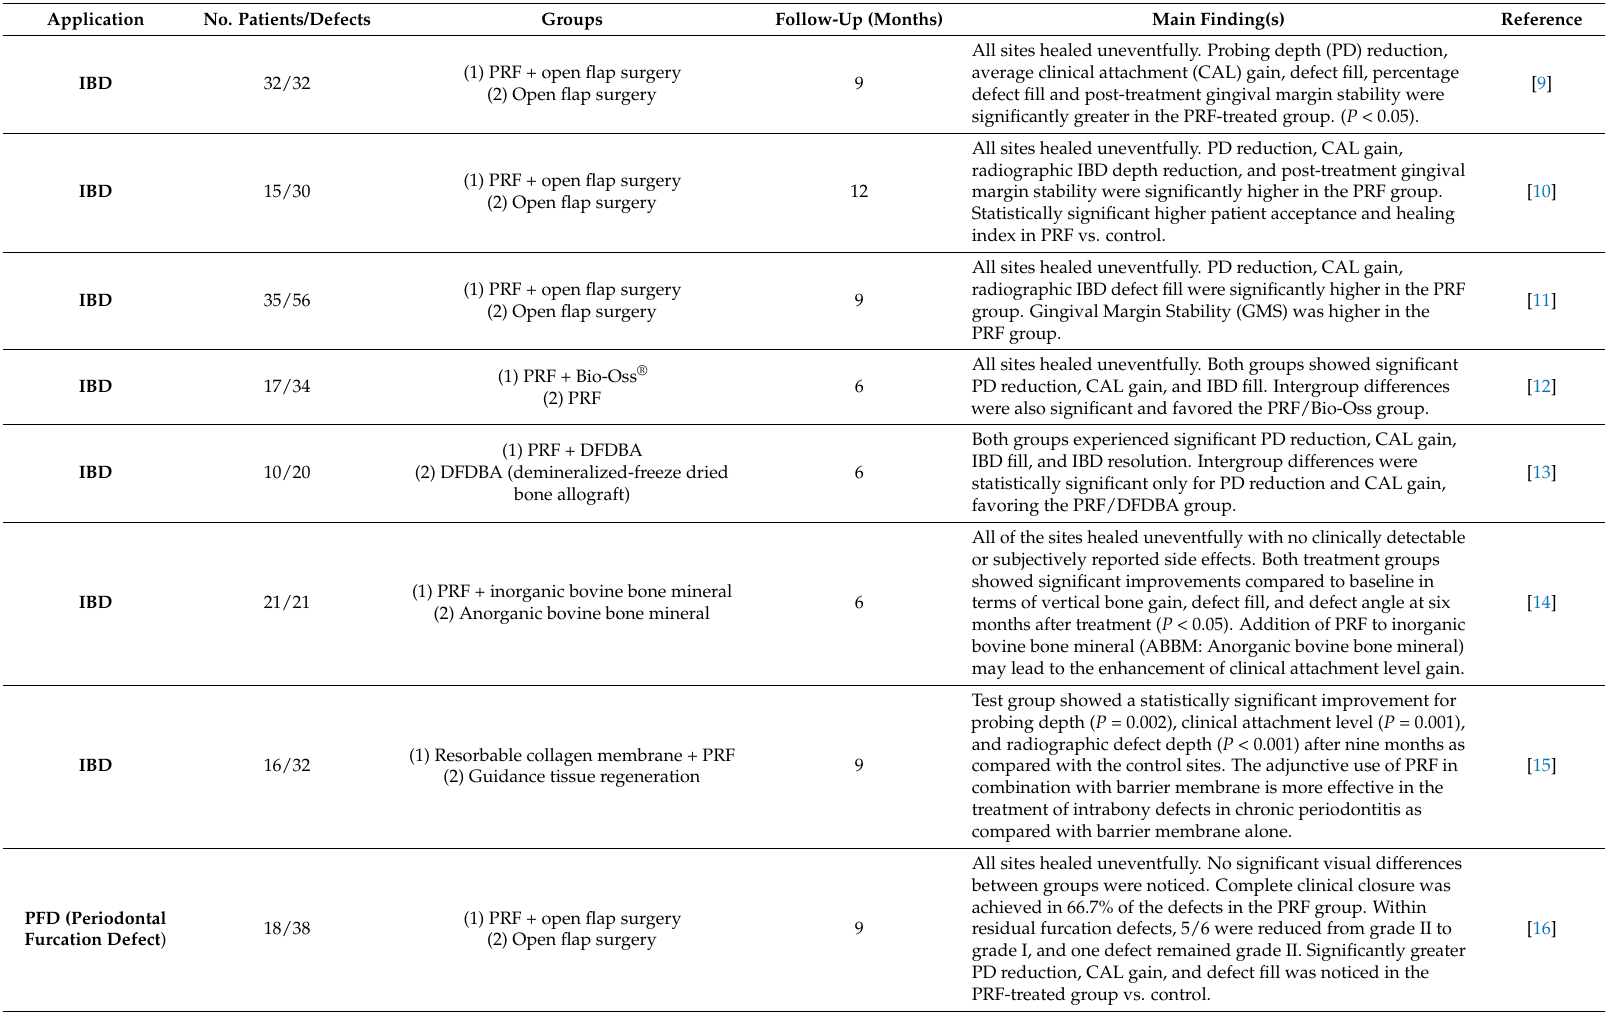
Table 1. Summary of clinical literature (randomized clinical trials, or RCTs) on L-PRF use in oral and maxillofacial Surgery. IBD: intra-bony